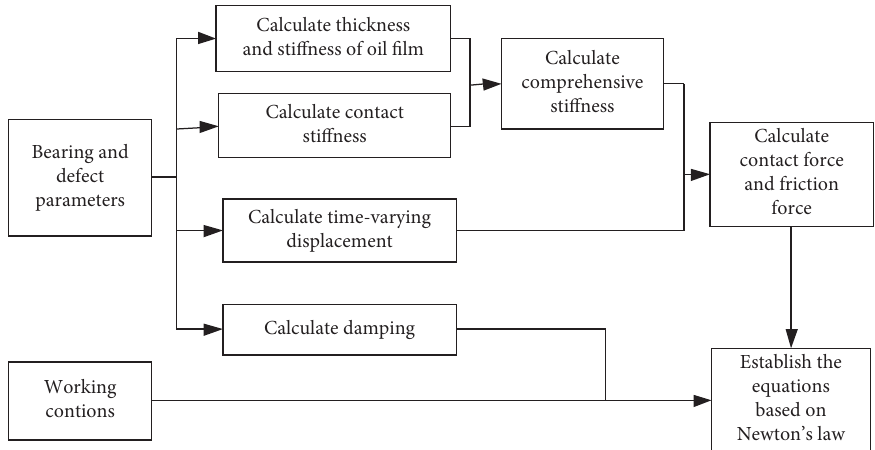
Figure 1: Technical flowchart of modeling